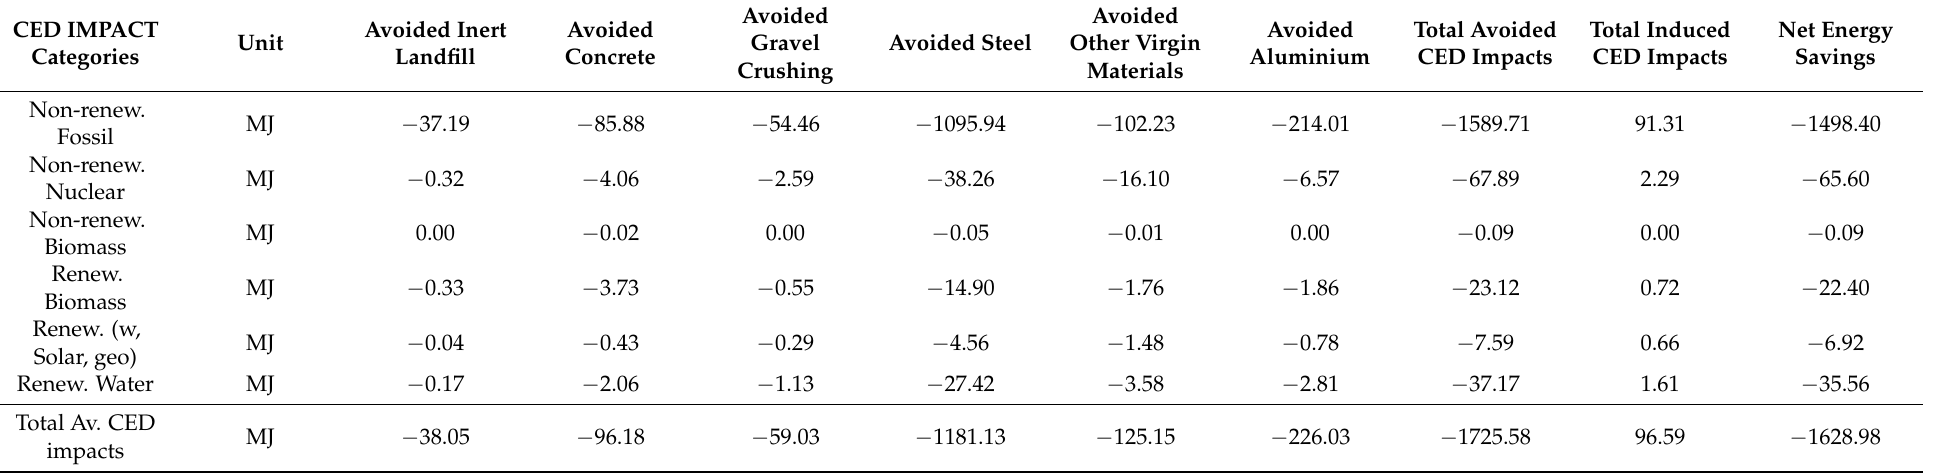
Table 4. Avoided versus induced characterized CED impacts associated to the collection and recycling of 1 tonne of